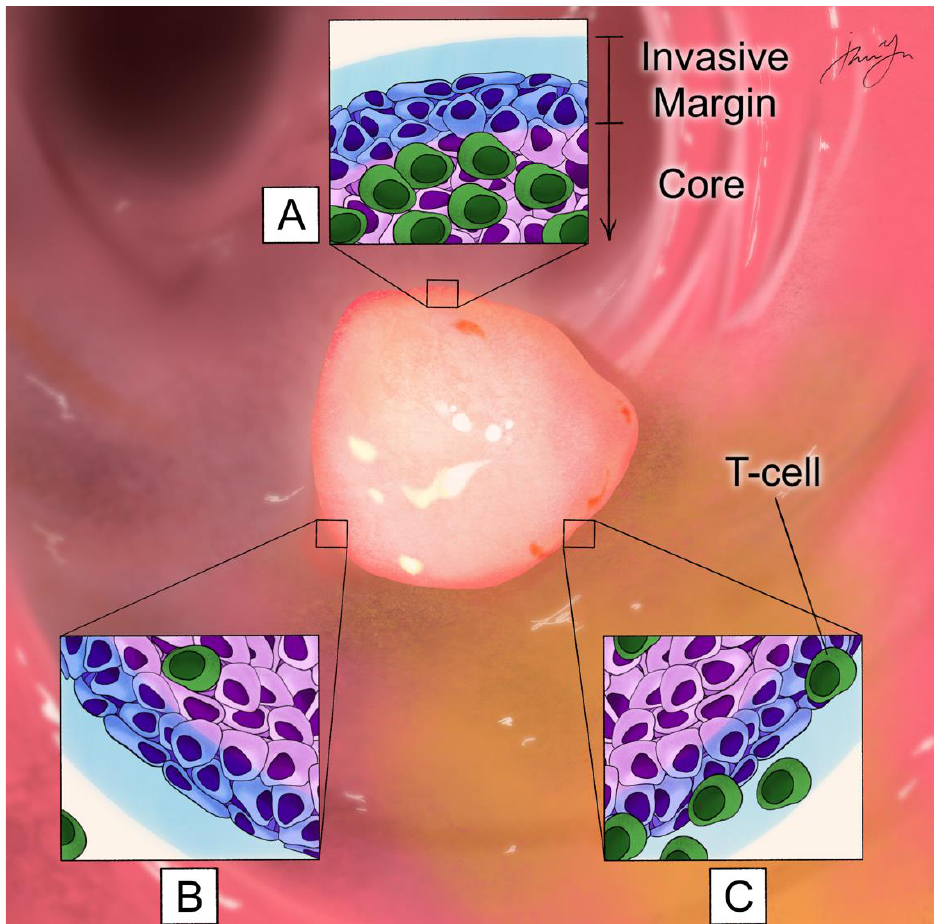
Figure 1. The principle of immunoexclusion is based on the concept that tumors can be hot, cold, or excluded based on the location and density of T cells in the tumor core and/or invasive margin of the tumor, which is defined as a 1 mm region centered on the interface of malignant cells and normal host cells. ( A ). Hot tumors have high T-cell density in the core of the tumor. ( B ). Cold tumors have low T-cell density in the core and invasive margin of the tumor. ( C ). Excluded tumors have high T-cell density only in the invasive margin of the tumor.